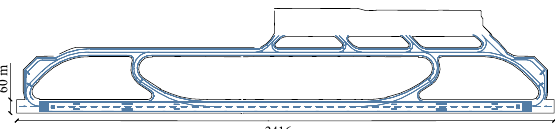
Fig. 1. Airside: runway, taxiway, and ramps